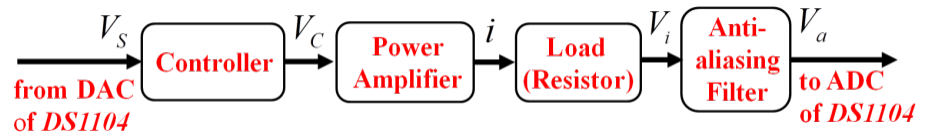
Figure 5. Block diagram of system identification on commercial controller.